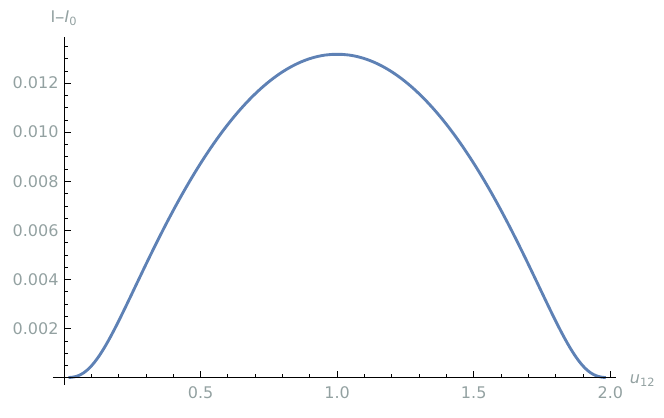
Figure 16 . ( I (cid:0) I 0 ) as a function of u 12 . The parameters are: (cid:30) r = 8 ; m = 1 ; (cid:15) = :